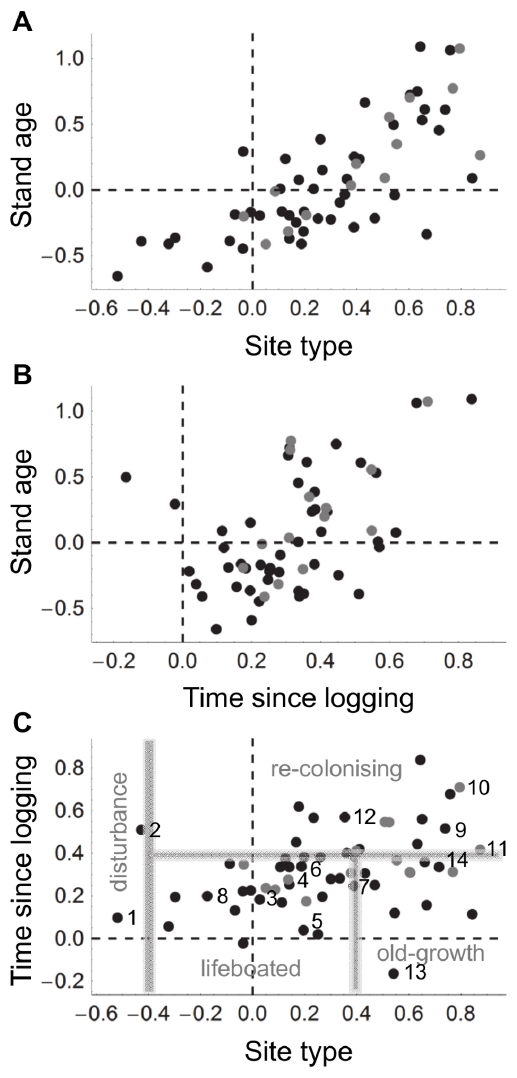
Figure 3. Co-variation among species specific regression coefficients between the covariates. a) Site type and stand age, b) time since logging and stand age, and c) site type and time since logging. Negative values of site type refer to retention sites and positive to conservation sites. Mosses are depicted in black and liverworts in grey. Species-specific regression coefficients are based on the presence- absence model. See File S3 for the species specific regression coefficients for each covariate and Table 2 for the numbered species in c).